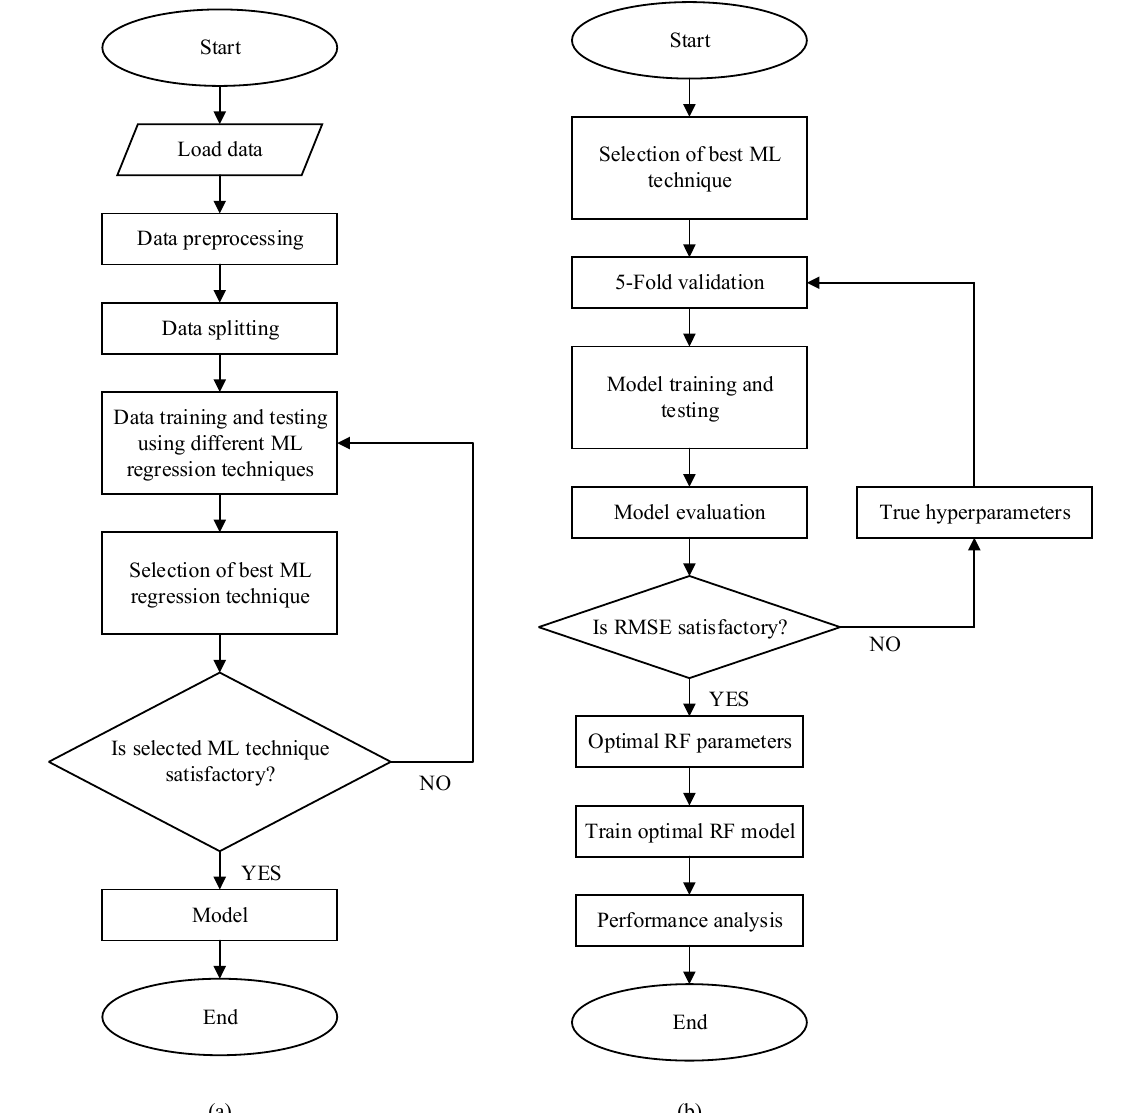
Figure 1. ( a ) Flowchart for the Proposed RF-LS-BPT model; ( b ) the RF-LS-BPT model and its hyperparameter tuning implementation process.